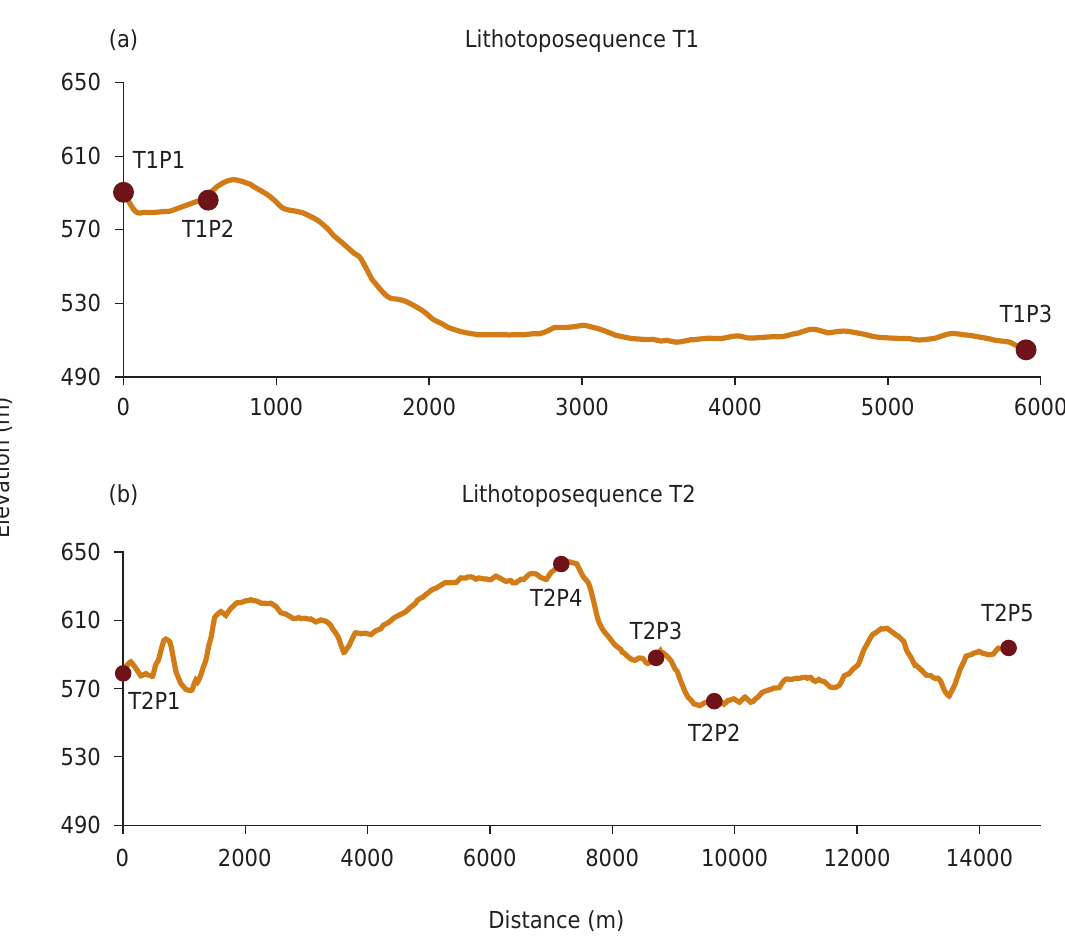
Figure 2. Topographic profile of the lithotoposequences T1 (a) and T2 (b) of the study area at the Montes Claros (MG)